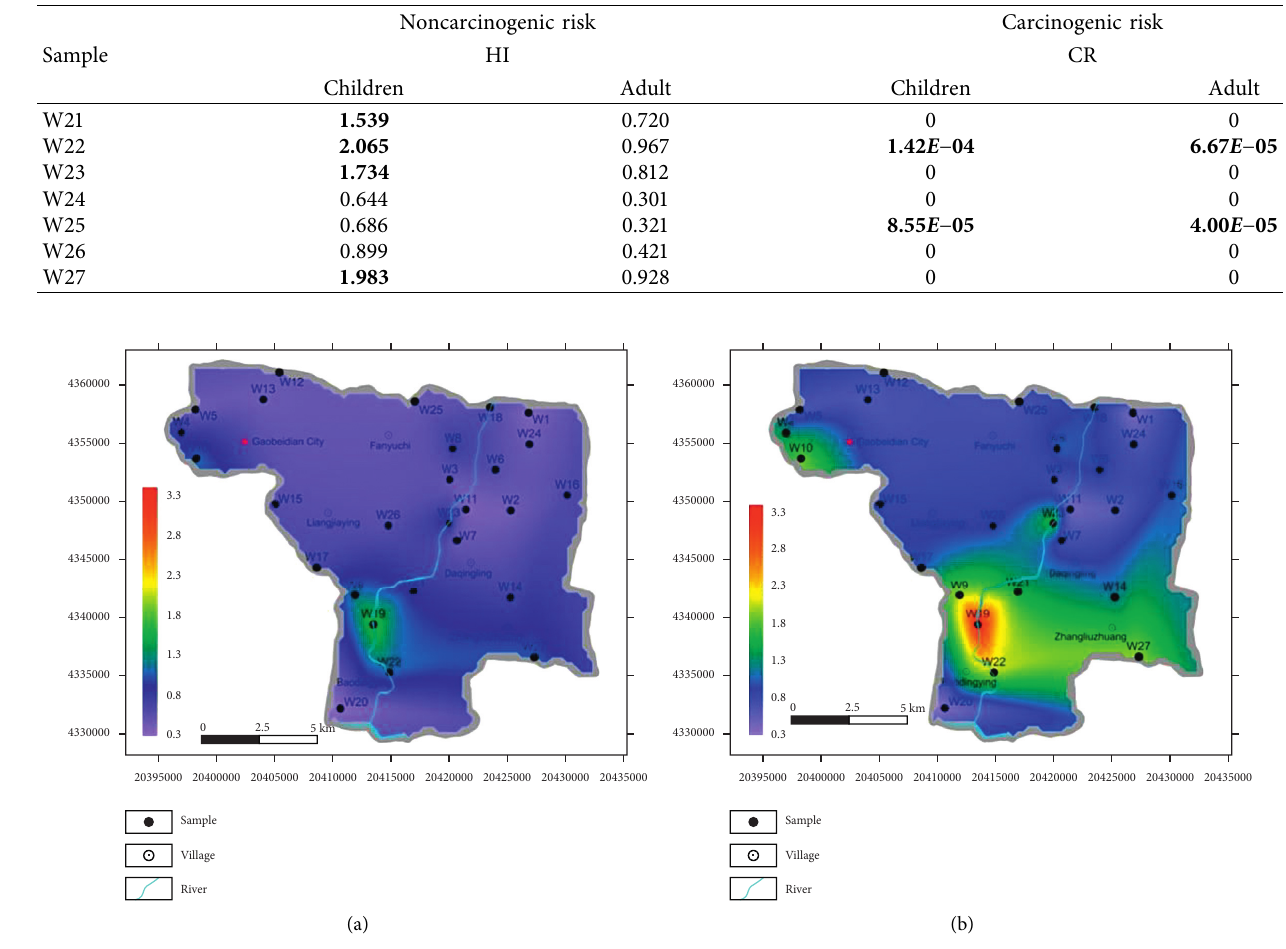
Figure 6: Spatial zonation of noncarcinogenic risk for adults and children.